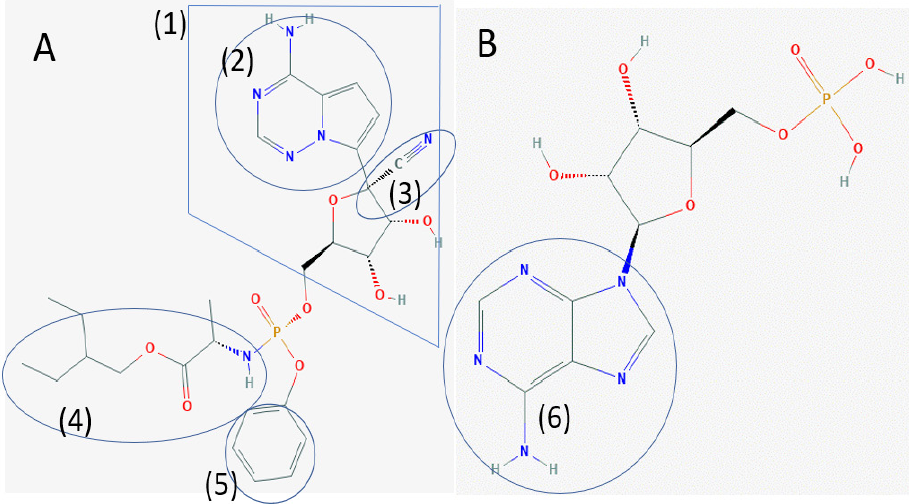
Fig. 1. Chemical structure of remdesivir 41 (A) and adenosine 5’-monophosphate (B). A: (1) Modified C-adenosine (GS-441524), (2) modified adenine nucleobase, (3) cyano group at C-1 of the ribose, (4) amino acid ester substituent of the phosphoric acid moiety, (5) phenyl substituent of the phosphoric acid moiety. B: (6)